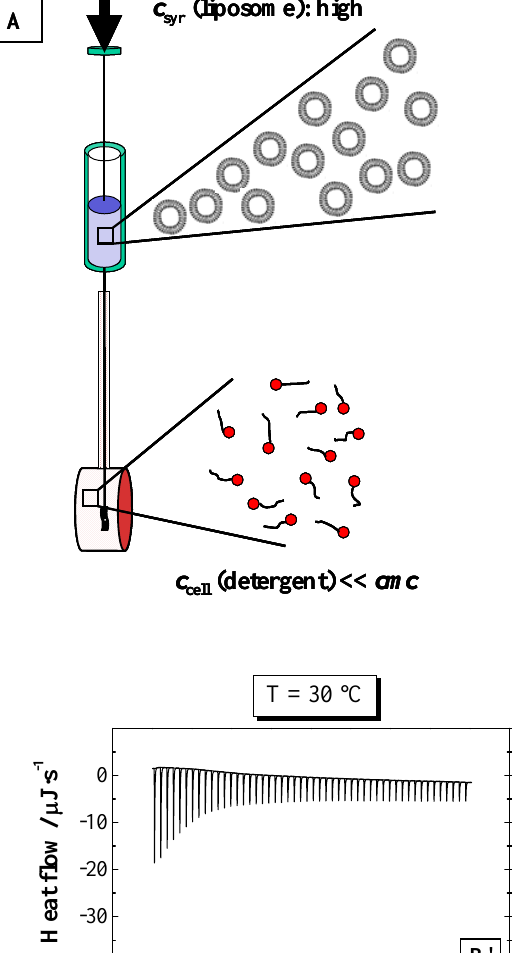
Figure 3. (A) Schematic representation of an ITC partition experiment. The syringe is loaded with a liposome dispersion and is titrated to a monomer detergent solution ( c Titration of a SPC (soy bean phosphatidylcholine) liposome dispersion (20 mM, 0.1 M NaCl, pH 7.4) into NaC (4 mM, 0.1 M NaCl, pH 7.4) in steps of 5 μ l, 50 injections. (B’) calorimetric traces at 30 ° C and (B’’) 60 ° C. The derived reaction heat Δ Q of each injection versus lipid concentration (SPC) in the cell is represented in (C’) for 30 ° C and (C’’) 60 °